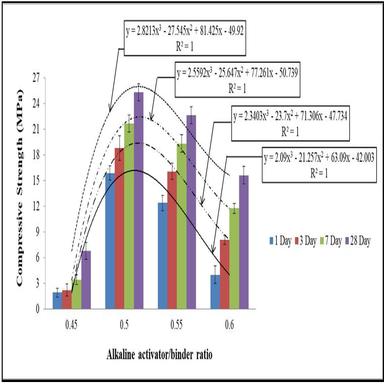
Coefficient of determination (R2 ) for effect of Alakline activator/binder ratio on 1, 3, 7 and 28 day compressive strength.